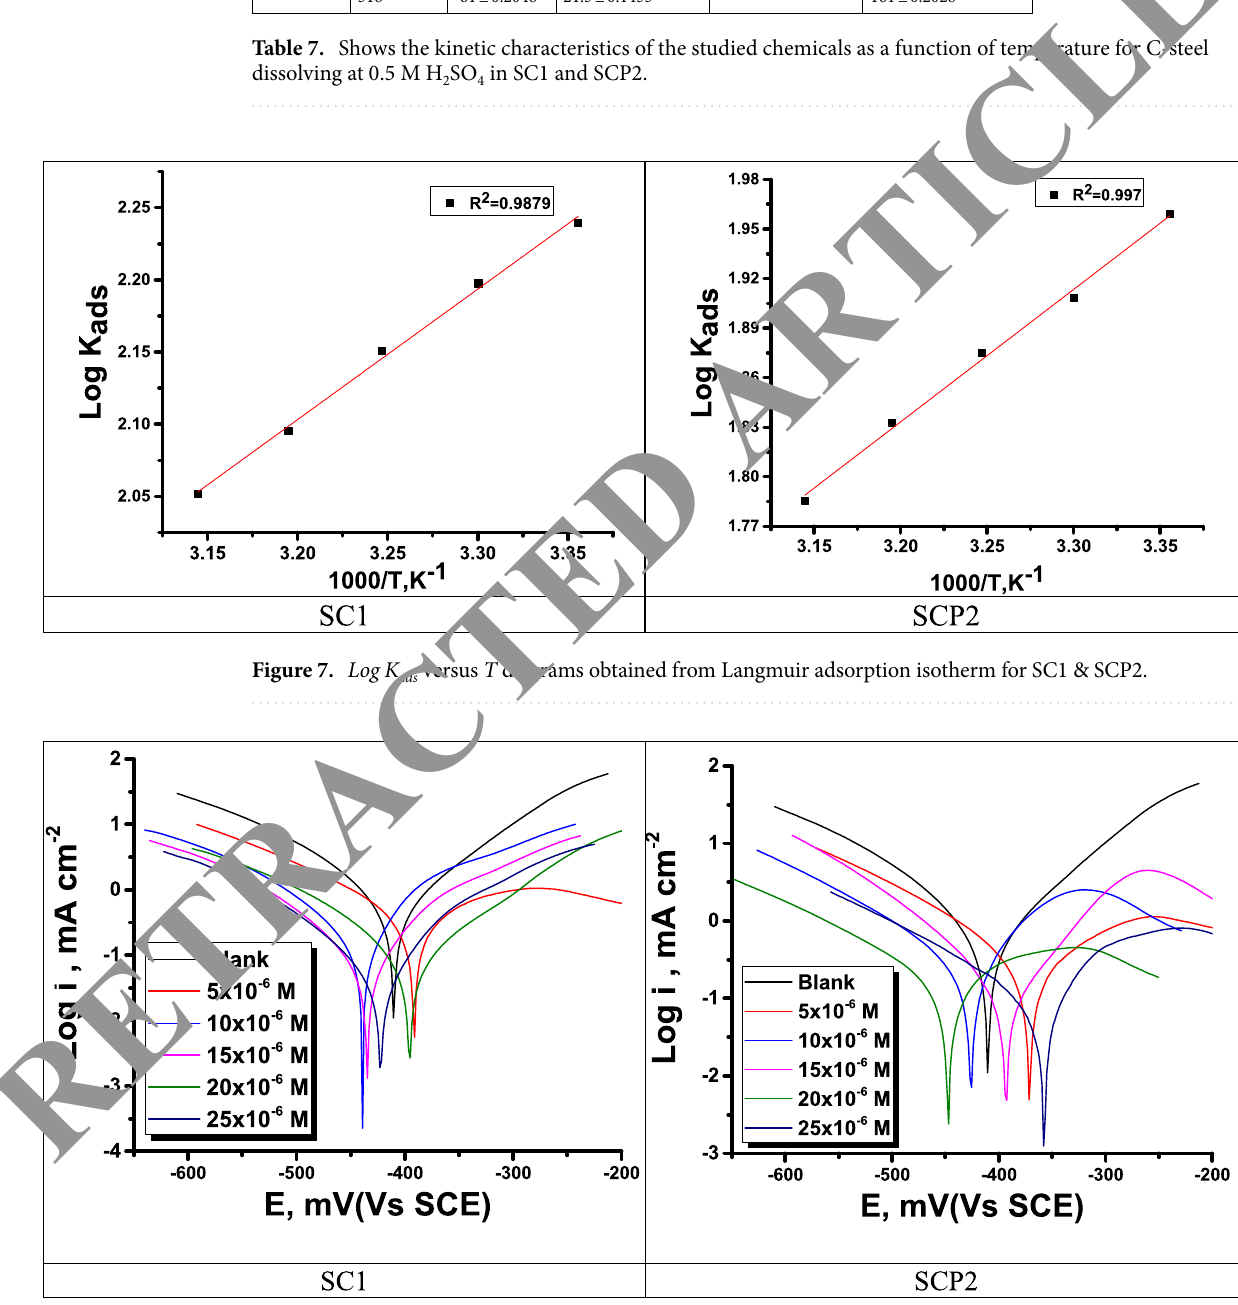
Figure 8. PP diagrams for the dissolution of C-steel in 0.5 M H 2 SO 4 with and without altered doses of SC1 & SCP2 at 298